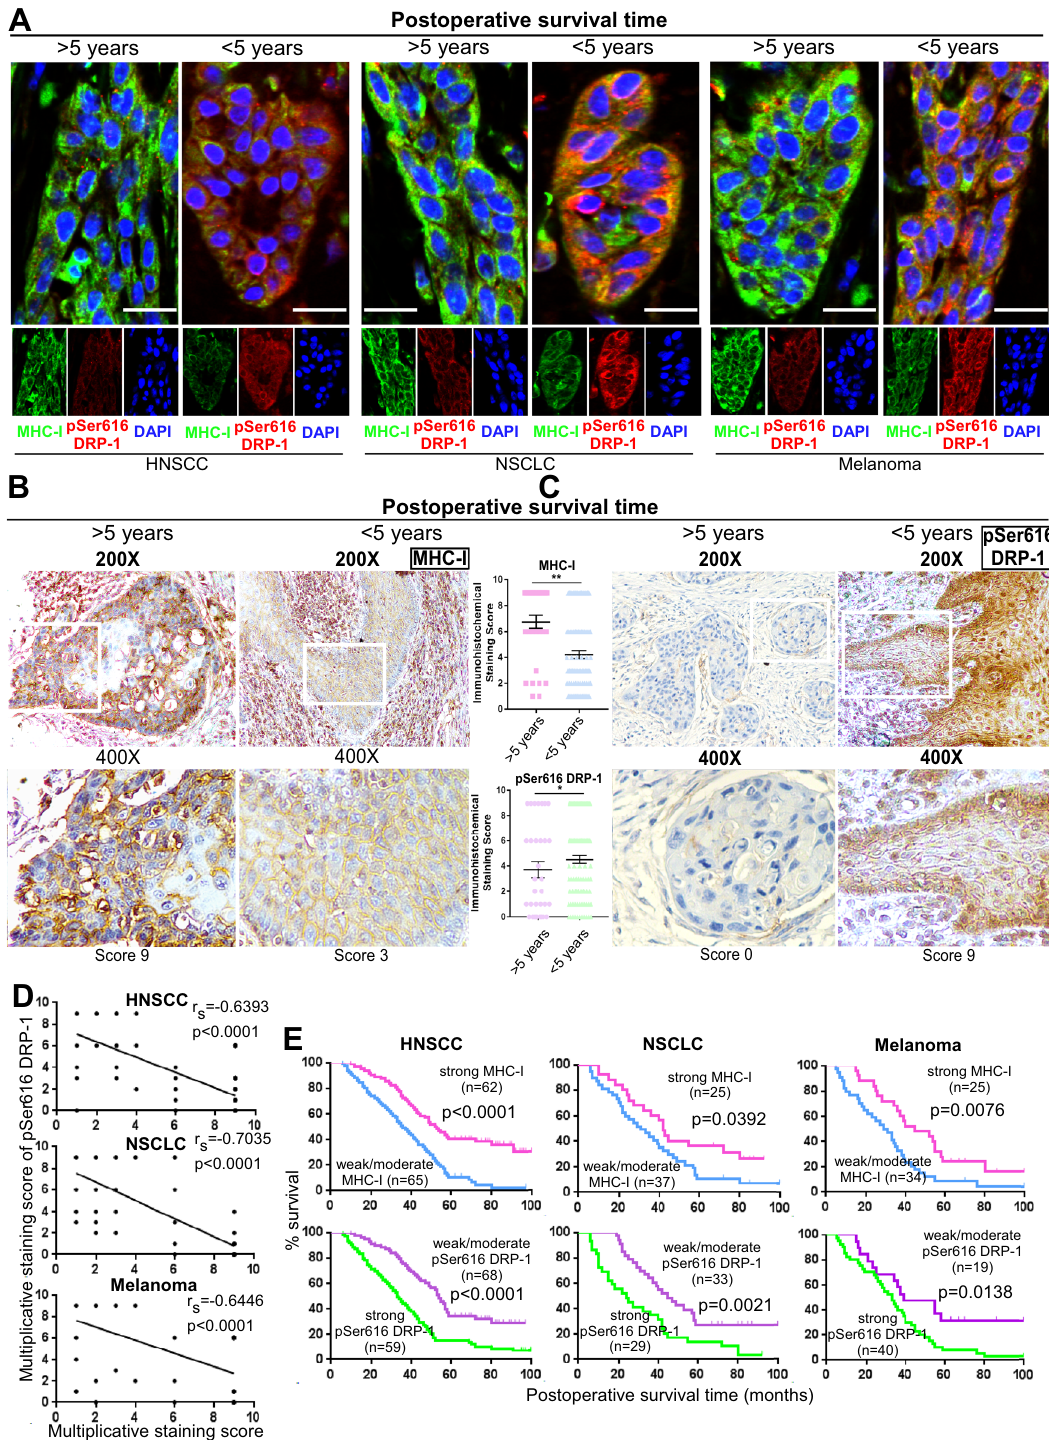
Fig. 1 Low pSer616 DRP-1 correlates with high MHC-I and indicates a better prognosis in cancer patients. A Representative immuno fl uorescence images for MHC-I and pSer616 DRP-1 of HNSCC, NSCLC, and melanoma patients with different postoperative survival time (MHC-I: green, pSer616 DRP-1: red). DAPI, nuclear staining. Scale bars, 10 μ m. B , C Representative immunochemistry images and scores for MHC-I and pSer616 DRP-1 of HNSCC patients with different postoperative survival time. Magni fi cation, ×200 and ×400 (mean ± s.e.m; p < 0.0001 for MHC-I and p = 0.0173 for pSer616 DRP-1; ** p < 0.001 by two-tailed t -test). D Spearman order correlation analysis of MHC-I and pSer616 DRP-1 association in HNSCC, NSCLC, and melanoma based on IHC score ( p < 0.0001 for HNSCC, NSCLC and Melanoma) E Kaplan – Meier survival curves for HNSCC, NSCLC, and melanoma patients are plotted for pSer616 DRP-1 and MHC-I expression. Survival differences were analyzed using log-rank test ( p < 0.0001 for HNSCC, p = 0.0392, p = 0.0021 for NSCLC and p = 0.0076, p = 0.0138 for